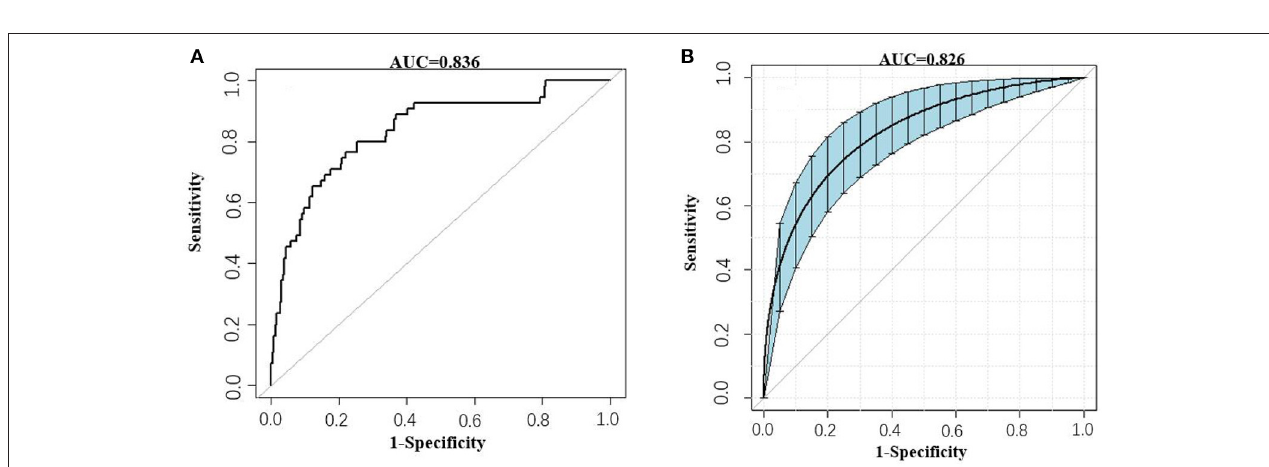
FIGURE 4 | ROC curves of the AKI model. (A) Prediction of AKI (AUC = 0.84 95%CI 0.77–0.90). (B) Prediction of AKI by the bootstrap (500 resample) method. Blue shading shows the bootstrap estimated 95% CI with the AUC (AUC = 0.83 95%CI 0.75–0.89).